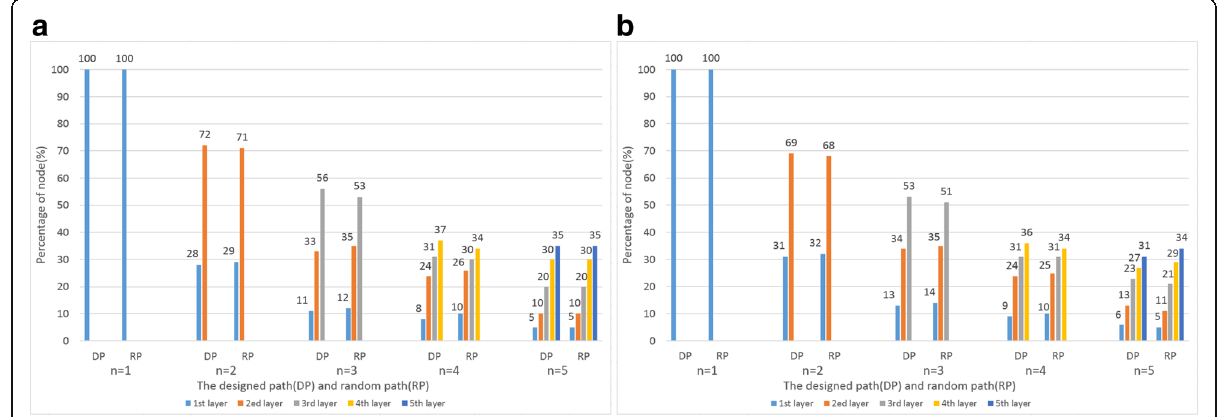
Fig. 4 Percentage of nodes synchronized at different layers. a The densely deployed network case. b The sparsely deployed network